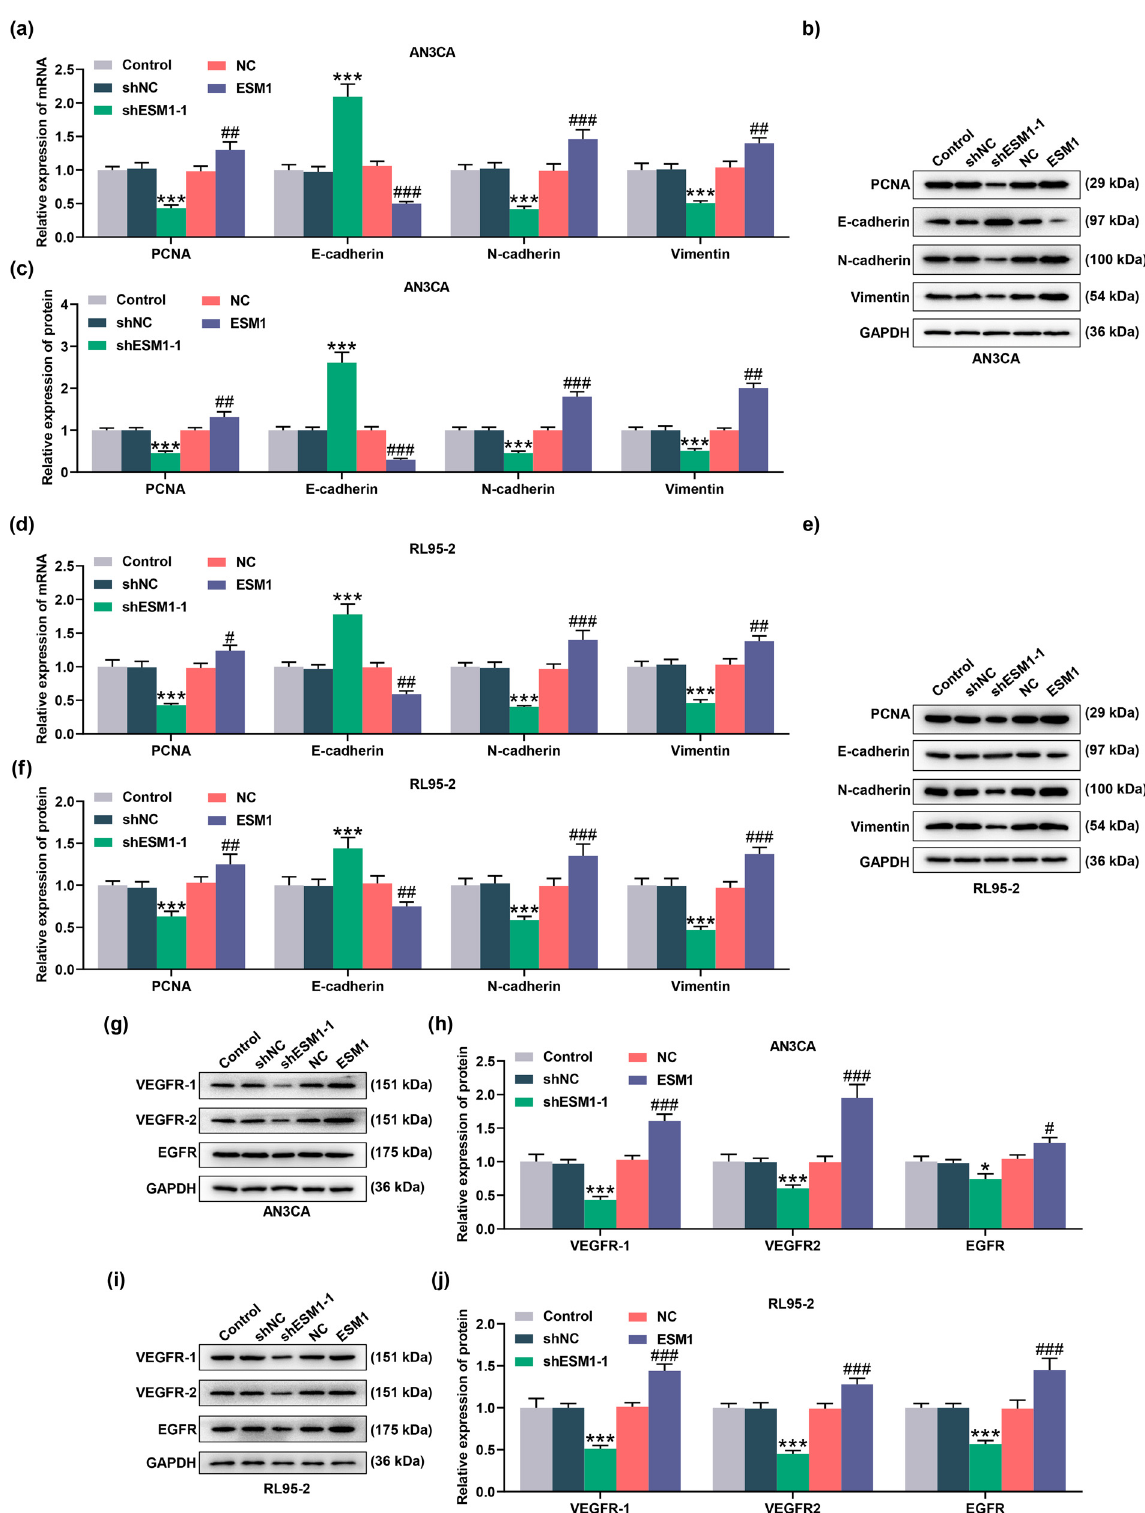
Figure 5: ESM1 a ff ected the proliferation - , epithelial - mesenchymal transition ( EMT )- , and angiogenesis - related proteins in EC cells. ( a – f ) The e ff ects of ESM1 overexpression or its silencing on the mRNA and protein expressions of PCNA, E - cadherin, N - cadherin, and Vimentin were evaluated by qRT - PCR and Western blot. ( g – j ) Western blot was used to detect the protein expressions of VEGFR1, VEGFR2, and epidermal growth factor receptor ( EGFR ) in AN3CA or RL95 - 2 cells. GAPDH was selected as the internal reference gene. * P < 0.05, *** P < 0.001 vs ShNC; # P < 0.05, ## P < 0.01, ### P < 0.001 vs